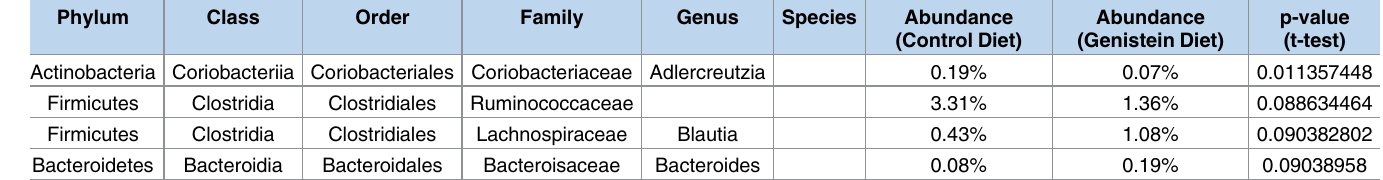
Fig 6. Microbiota change four weeks after induction of tumor. (a) Phylum level changesin microbialabundance after inductionof tumor. There was no distinct difference in microbialcompositionbetweencontrol and GE diet groups. (b) 3D-PCoAplot (Bray Curtis) does not show any distinct clusteringof control-fed(red) and GE-fed mice (blue). https://doi.org/10.1371/journal.pone.0189756.g006 GE metabolism In each of the mice treated with GE, the major urinary metabolites were GE phase II conju- gates, GE sulfate ( m/z 349.0017) and GE β -glucuronide ( m/z 445.0765), and GE sulfate/ β -glu- curonide double conjugate ( m/z 525.0344) (Fig 7). Each of these conjugates had MSMS spectra consistent with their chemical forms. There was no evidence of disulfate or di- β -glucuronide double conjugates in these mouse urines as noted by Soukup et al.[38]. The sulfate/ β -glucuro- nide double conjugate of GE was particularly elevated in mouse #4 humanized with fecal mate- rial from a patient after treatment with DOX. The extracted ion chromatogram (EIC) of m/z 349.0017 contained at least two unresolved components (particularly for mouse #4), presum- ably positional isomers of GE-sulfate. The EIC of m/z 445.0765 had two chromatographically separated peaks, both with MSMS spectra that were consistent with their being GE- β - Table 3. Bacterial species showing significant changes in relative abundance after induction of